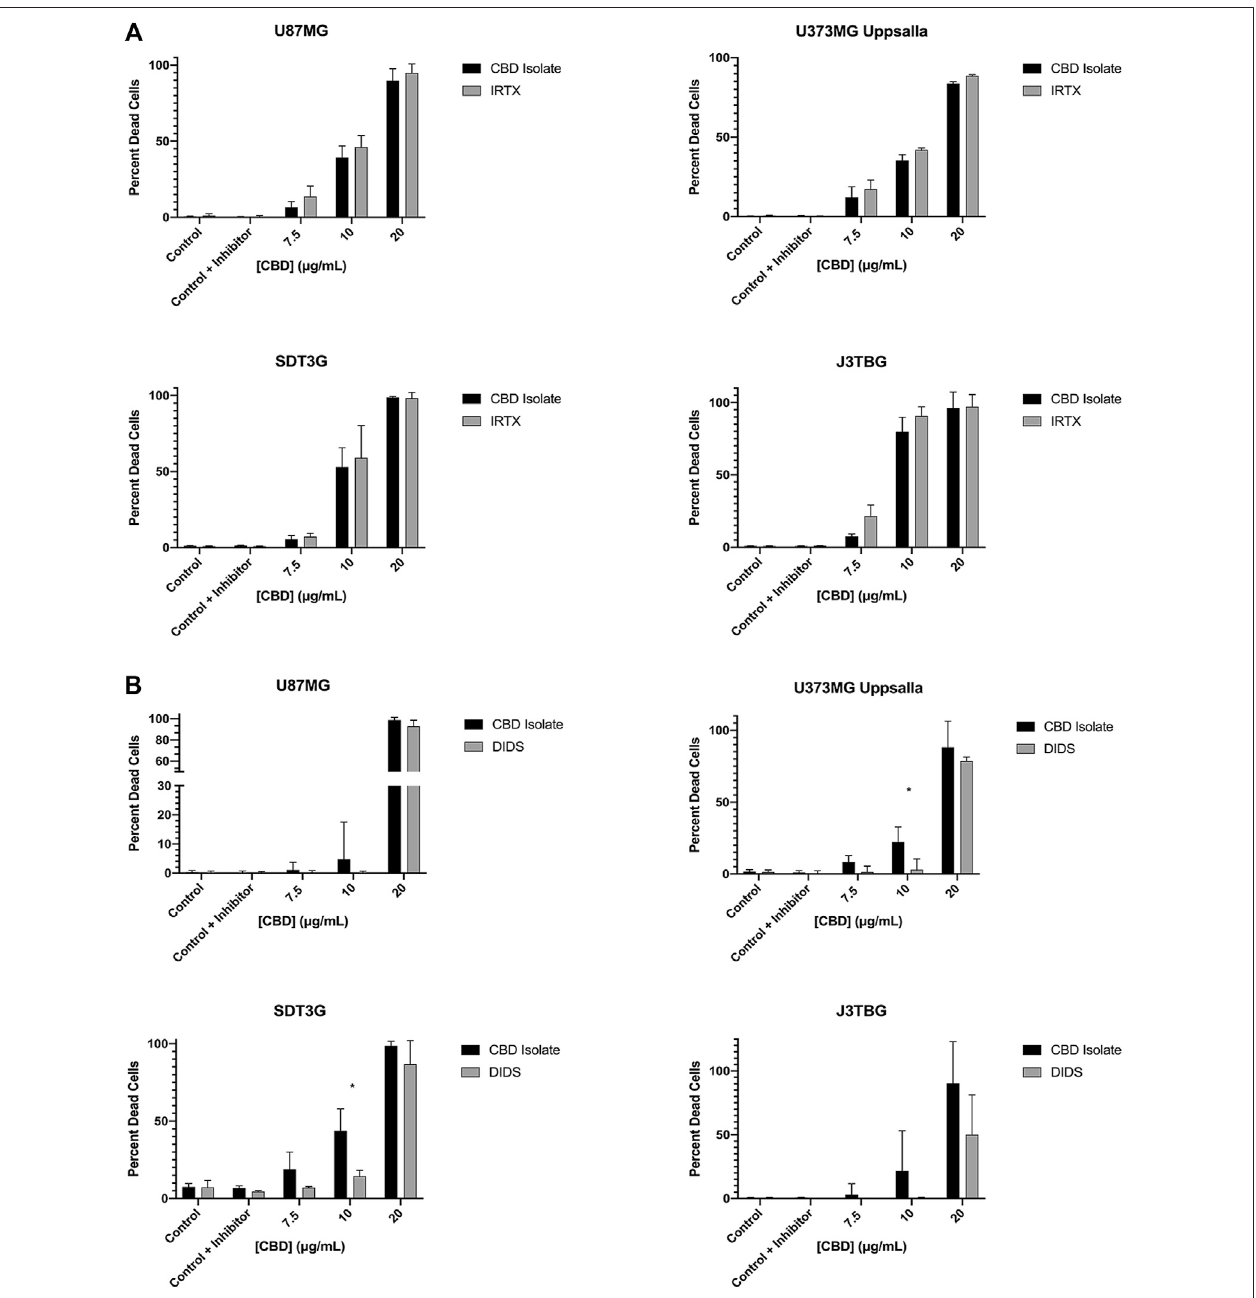
FIGURE 5 | CBD mediated cytotoxicity involves VDAC1 but not TRPV1. (A) U87MG, U373MG, J3TBG, and SDT3G Glioma cells were treated with CBD isolate (0 – 20 μ g/ml) and IRTX (1 µM) concurrently for 96 h and cytotoxicity determined using the green fl uorescent dye, YOYO-1. Representative of n (cid:1) 3 independent experiments expressed as mean ± SD. *P (two-tailed t -test). (B) Cytotoxicity of glioma cells treated with CBD isolate (0 – 20 μ g/ml) and DIDS (50 µM) concurrently for 96 h. Data shown are from n (cid:1) 3 independent experiments expressed as mean ± SD. *P (two-tailed t -test). U373MG Upsalla: 10 (0.02). SDT3G: 10 (0.003).